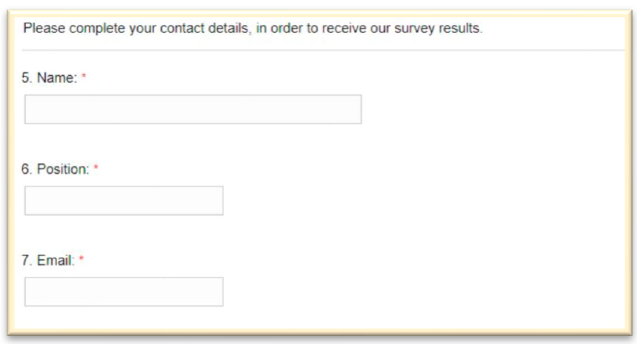
Figure A2. Questions for contact details.